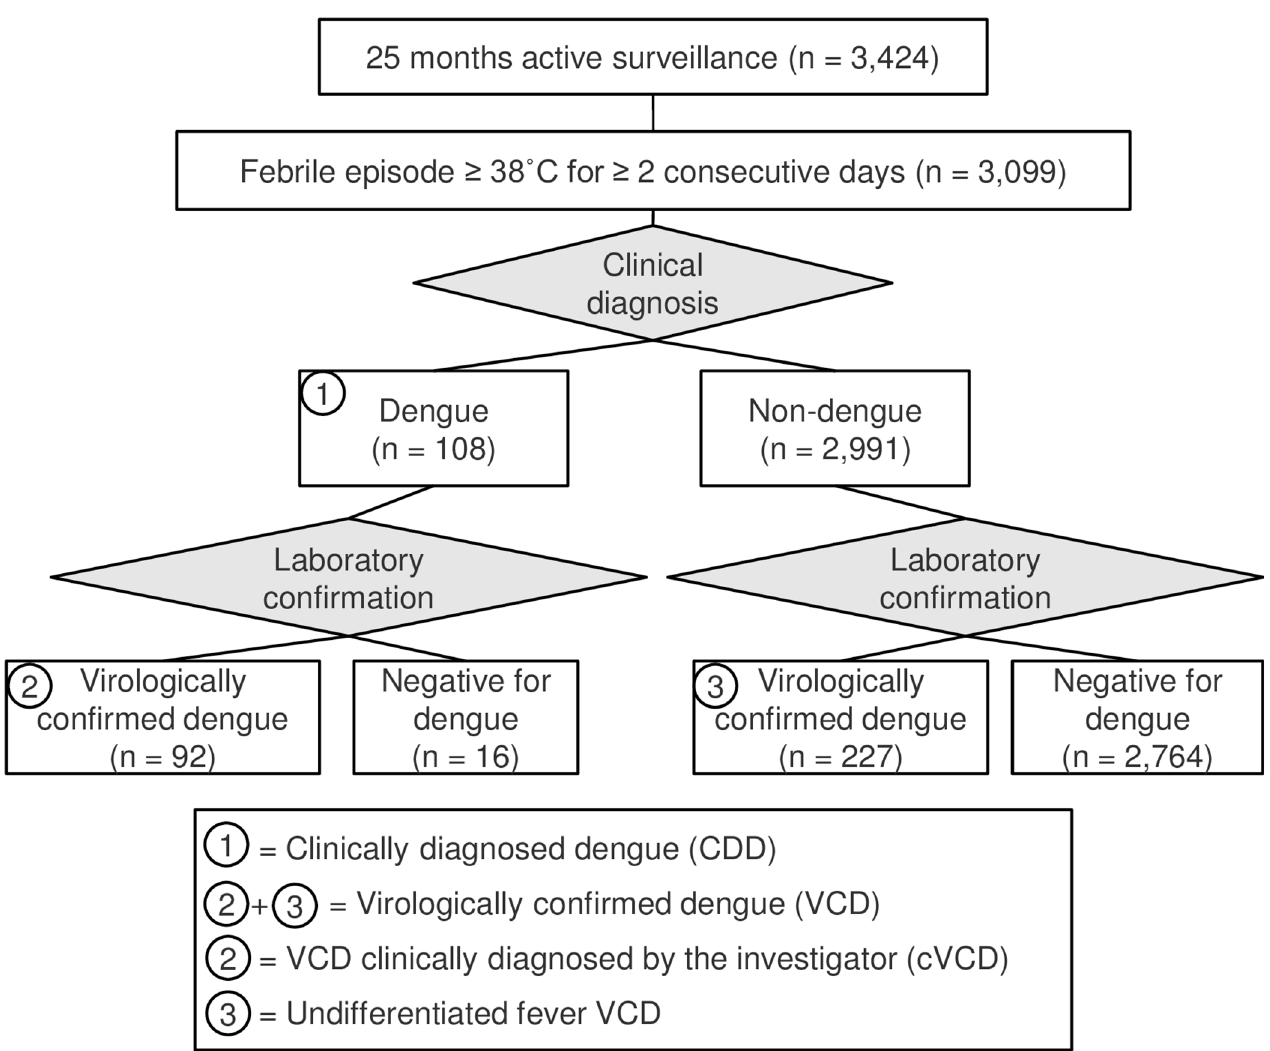
Fig 1. CYD14 study flow chart and source of each case definition. Control arm subjects were actively followed for 25 months to detect episodes of fever (cid:1) 38°C for (cid:1) 2 consecutive days. Febrile episodes were recorded and clinically diagnosed as dengue based on 1997 WHO guidelines, or an alternative etiology. Irrespective of clinical diagnosis, serum samples were taken for virological confirmation of dengue by detection of NS1 antigen by immunoassay and viral RNA by RT-PCR. A positive result for either laboratory test was considered confirmatory of dengue. Clinically diagnosed dengue (CDD): all episodes that were clinically diagnosed as dengue, irrespective of virological confirmation. VCD: all virologically confirmed dengue episodes, irrespective of clinical diagnosis. cVCD: all VCD episodes that were also clinically diagnosed as dengue. UF-VCD: all VCD episodes that were not clinically diagnosed as dengue.